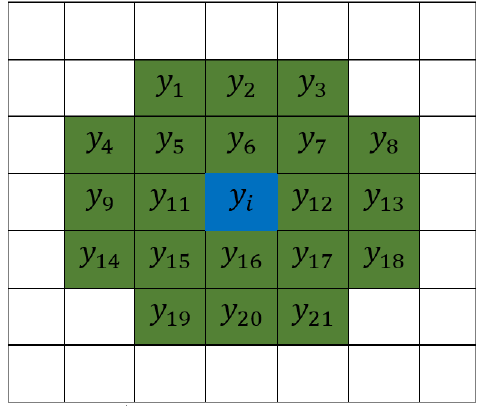
Figure 3. Layout of the grid used to calculate the mean. The model executed for each data set was: movingGrid rows = no.of.rows, columns = no.of.range, obsPhe = raw.observed.values, shapeCross = list(1:2,1:2,1:2,1:2), layers = c(1:1), excludeCenter = TRUE)